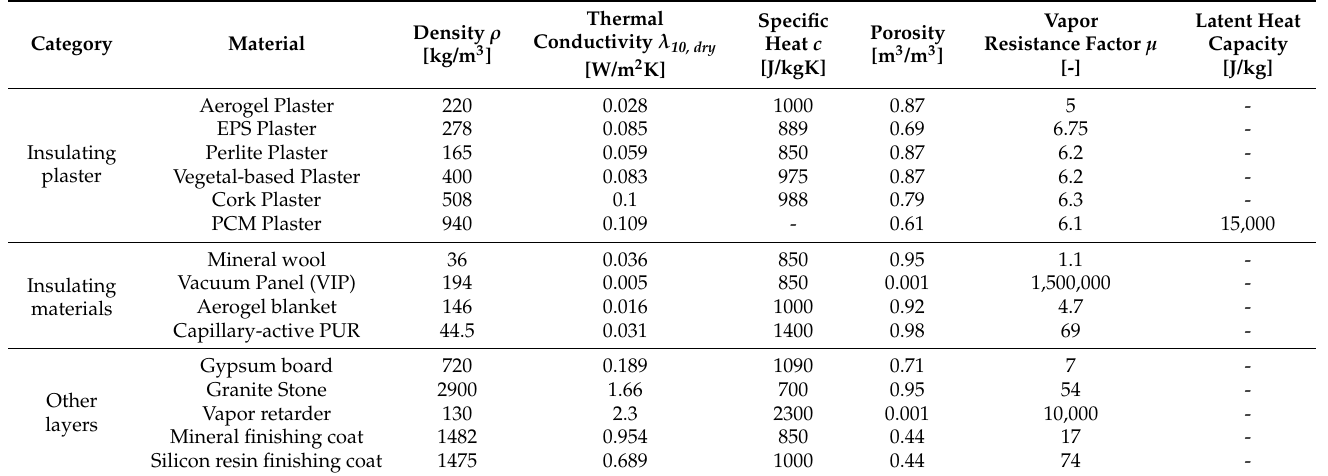
Table 2. Material properties.